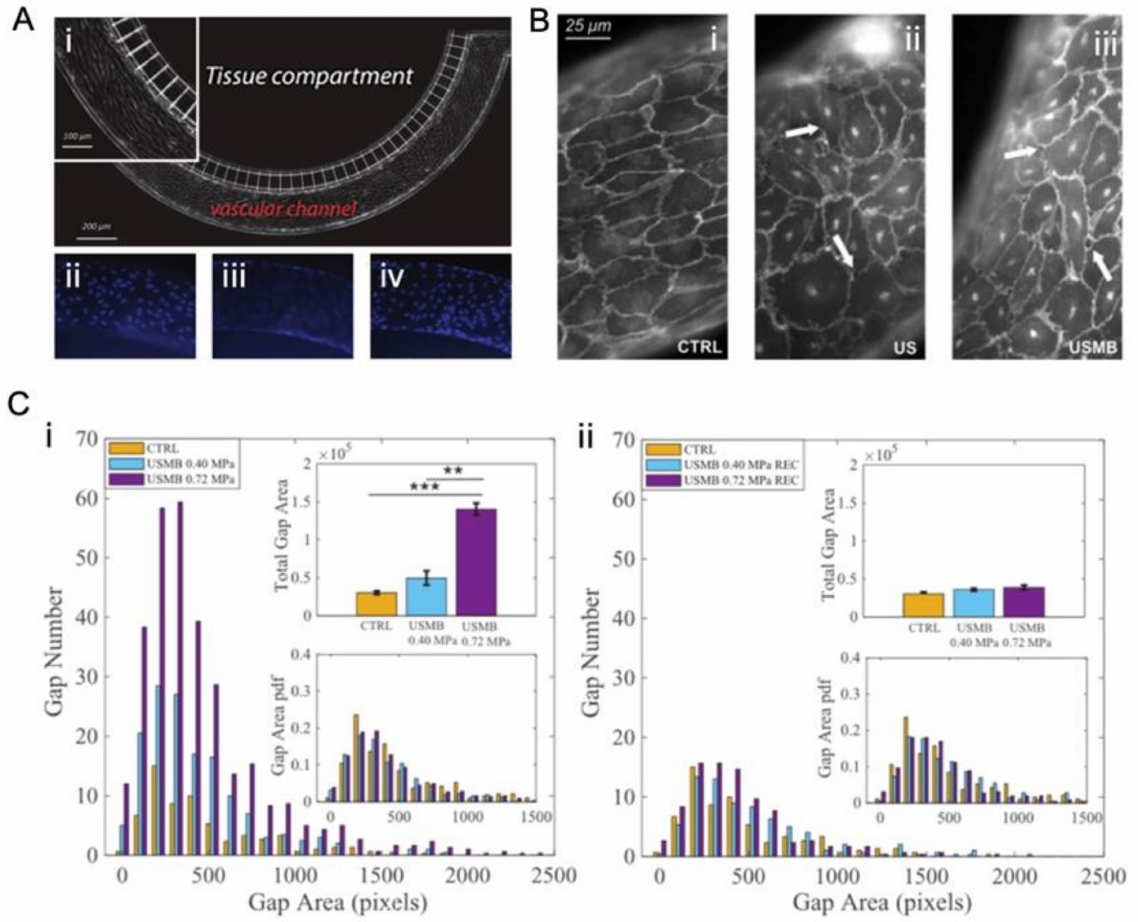
Figure 9. A 2D in vitro dynamic system for the study of ultrasound mediated opening of vascular barriers. ( A ) The model is composed of a tissue compartment and vascular channel [21]. ( i ) Brightfield image of HUVECs seeded in the vascular channel. The inset highlights the elongation of cells in the direction of flow. ( ii – iv ) Fluorescence images of cell nuclei after DAPI staining. ( ii , iv ) shows the